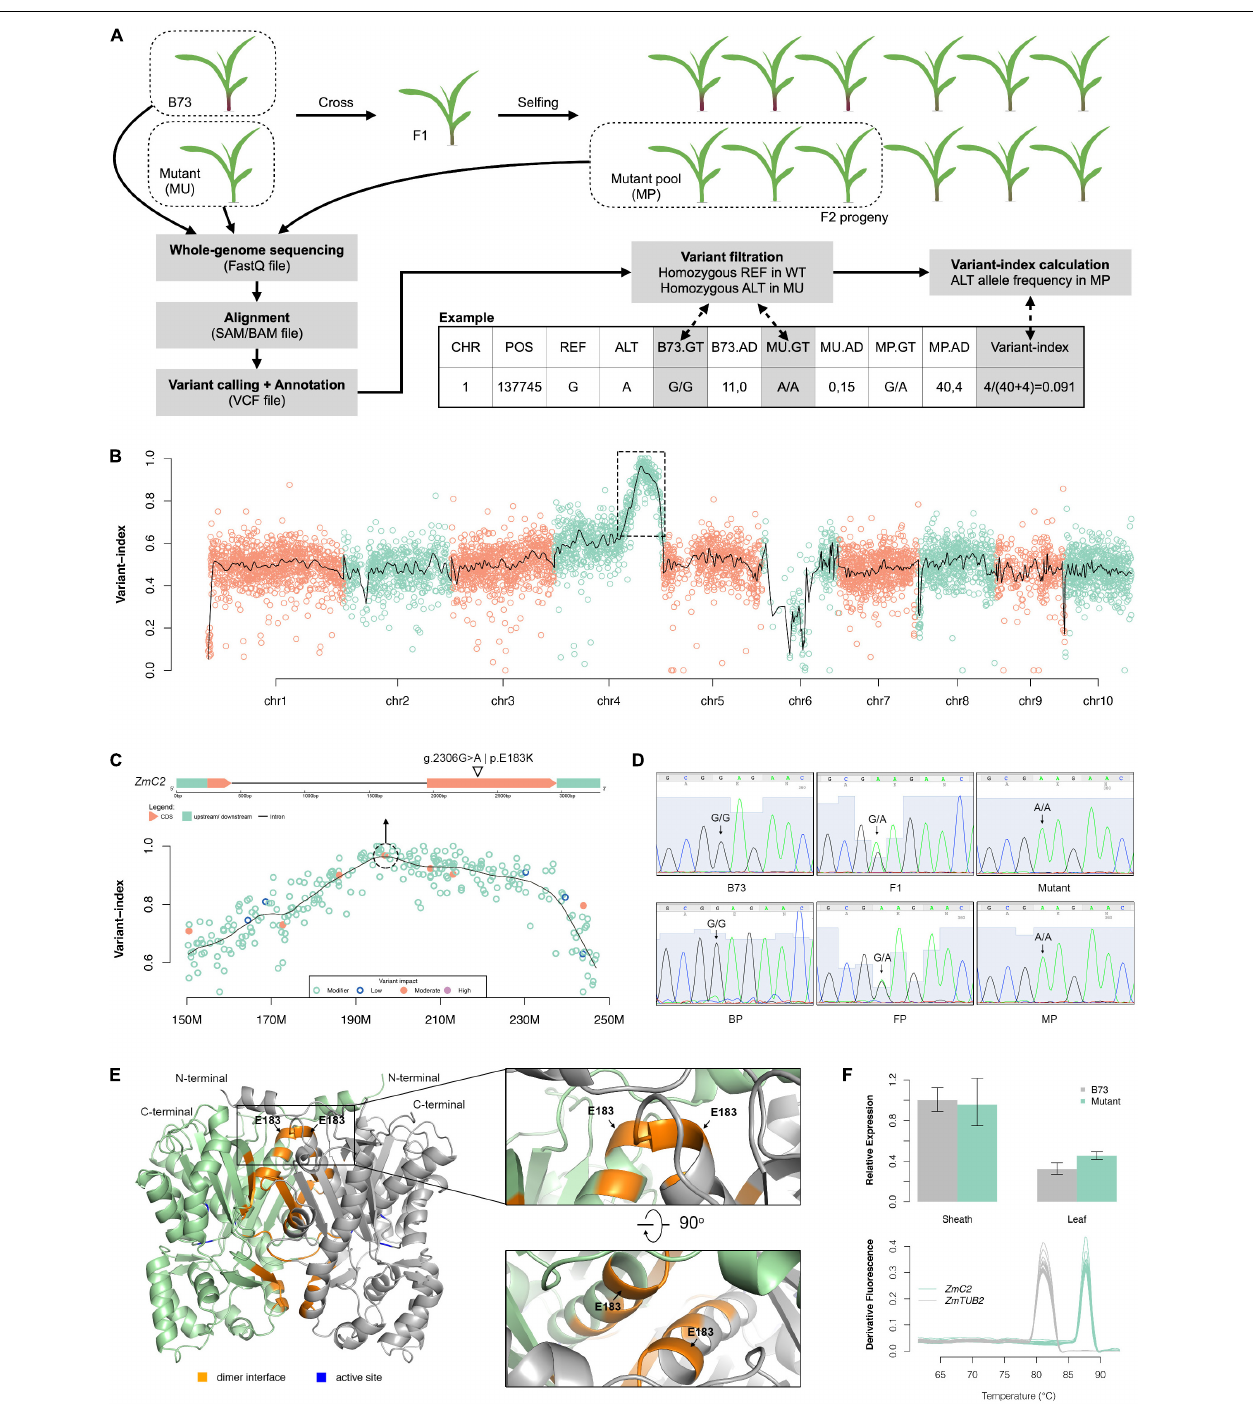
FIGURE 2 | Mapping of the colorless mutant. (A) Schematic diagram of the mutant mapping strategy. (B) Genome-wise visualization of variant-index. The black curve represents smoothing values by loess regression. The dashed-line box circles out the candidate region (chr4:150M–250M) harboring causal mutation. (C) Close-up visualization of variant-index in chr4: 150M–250M region (bottom) and gene structure of ZmC2 (top). (D) Sanger sequencing validation on g.2306G > A mutation of ZmC2 in parental, F1 and F2 progeny. BP, pool of B73-type F2 progeny; FP, pool of F1-type F2 progeny; MP, pool of mutant-type F2 progeny. (E) Three-dimensional (3D) structure of ZmC2. OsCHS1, chalcone synthase 1 ( Oryza sativa Japonica Group ) (GenBank: XP_015618054.1; PDB: 4yjy) with 92.15% alignment identity to ZmC2 serves as modeling template. (F) Expression pattern of ZmC2 in B73 and colorless mutant. The top panel displays qRT-PCR results and bottom panel displays melt-curves. ZmTUB2 , beta tubulin 4 ( Zea mays ) (NCBI accession: NP_001105457) serves as internal control. The first sheath and first leaf at three-leaf stage were used here.